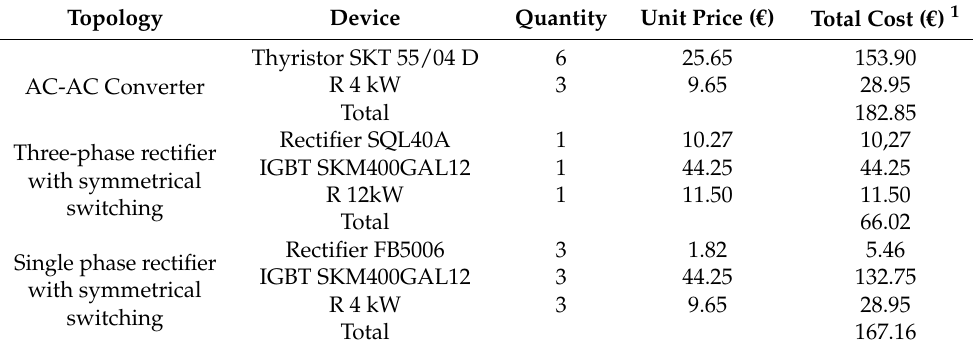
Figure 2. Topologies with symmetrical switching; ( a ) a three-phase rectifier; and ( b ) single-phase rec- tifier. Table 1. Cost of the topologies for ELC using the data of the Los Gallegos case of study.